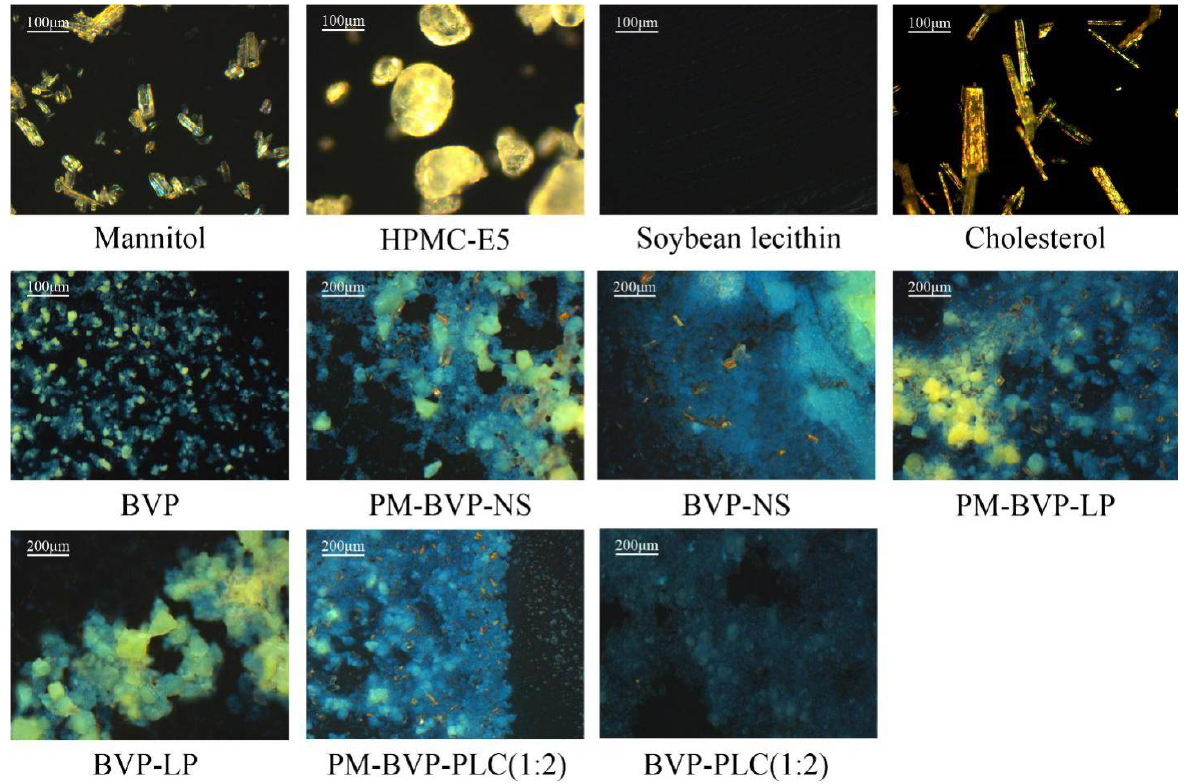
Figure 4. Polarized light microscopy (PLM) images of mannitol, HPMC-E5, soybean lecithin, cholesterol, BVP, PM-BVP-NS, BVP-NS, PM-BVP-LP, BVP-LP, PM-BVP-PLC (1:2) and BVP-PLC (1:2).